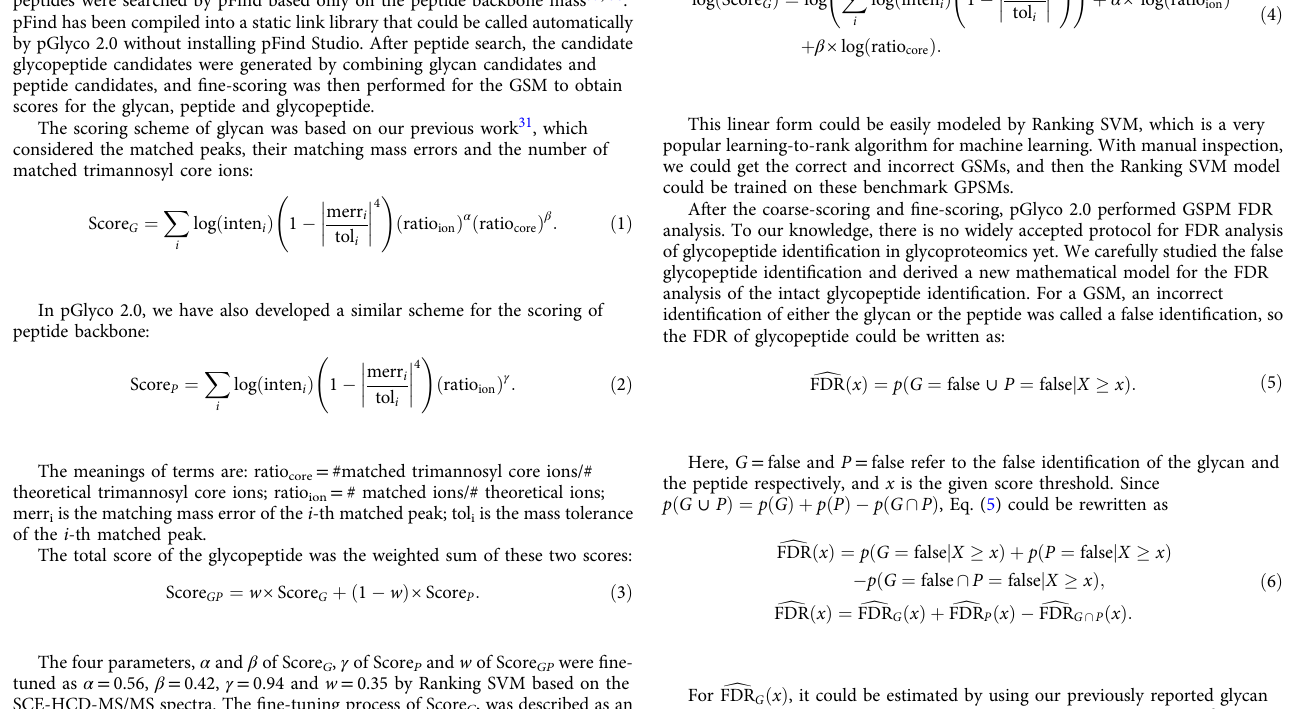
attached) could be deduced. Each glycan was scored by the number of matched Y ions, and any glycan with less than 2 trimannosyl core ions matched will be fi ltered out. And the top-k (K = 100 by default) candidate glycans were kept for the fi ne- scoring step. The second step is fi ne-scoring, which was a scoring scheme for a GSM. For each valid glycan candidate after coarse scoring, the corresponding candidate peptides were searched by pFind based only on the peptide backbone mass 37, 38 . pFind has been compiled into a static link library that could be called automatically